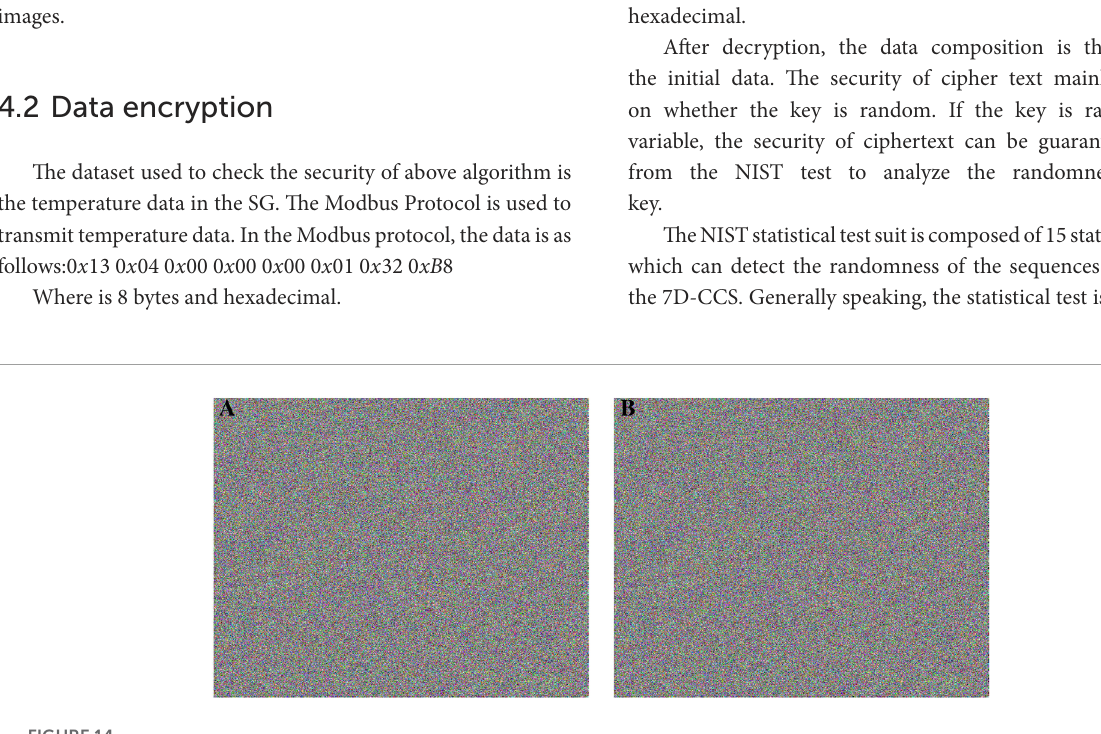
FIGURE 14 The results of wrong key, (A) Wrong key with picture 1 (B) Wrong key with picture